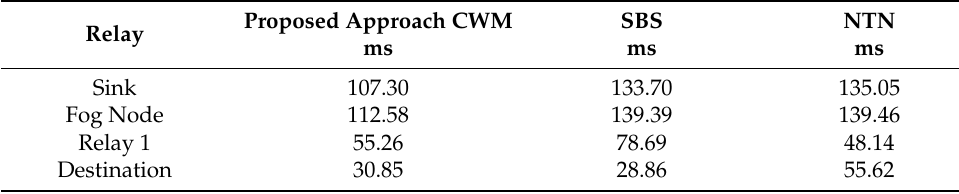
Table 3. Single nodes time in active mode using 1 Relay.